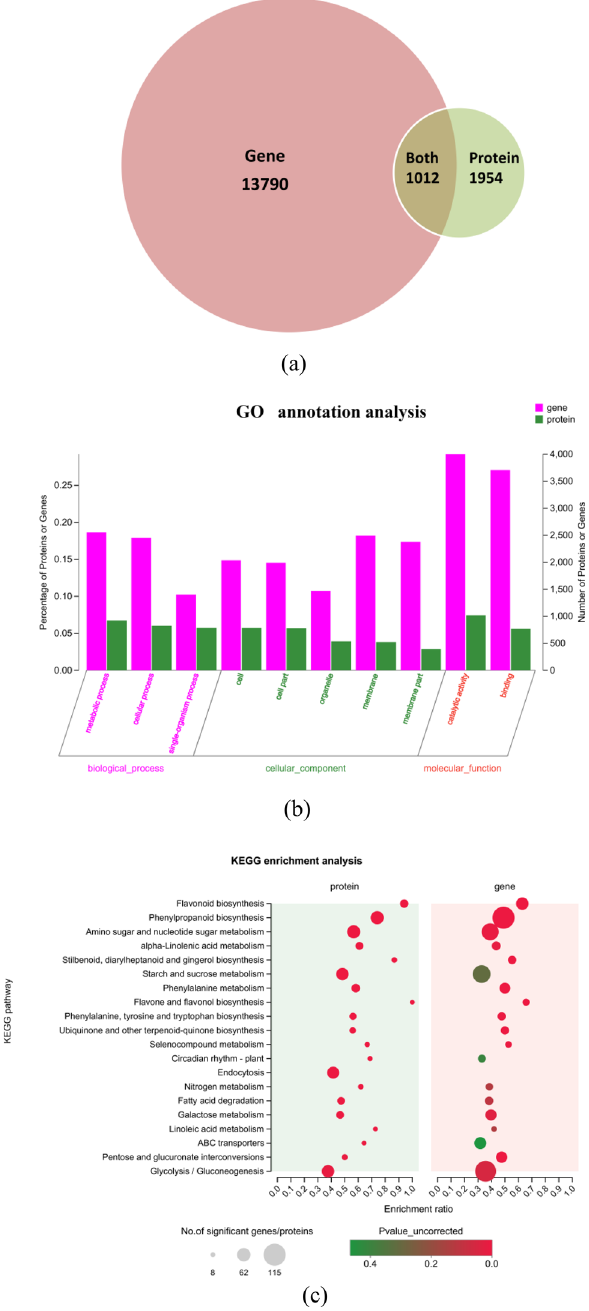
Figure 6. ( a ) Results of the correlation analysis of DEGs and DEPs. ( b ) Results of GO correlation analysis. The bars represent the secondary classifications of GO; bar height corresponds to the number of proteins or genes in the secondary classification; The abscissa represents the GO secondary classification term. The left ordinate represents the percentage of proteins or genes included in the secondary classification with respect to the total protein or gene number. The right ordinate represents the number of proteins or genes annotated to the secondary classification. ( c ) KEGG enrichment analysis results. The ordinate represents the pathway name, and the abscissa represents the enrichment rate (i.e., the ratio of the number of genes/proteins enriched in the pathway to the number of genes/proteins annotated in the pathway; a larger ratio corresponds to a greater degree of enrichment). Each bubble represents a path. The size of the bubble is directly proportional to the number of proteins or genes enriched in this pathway. The colors of the bubbles represent the